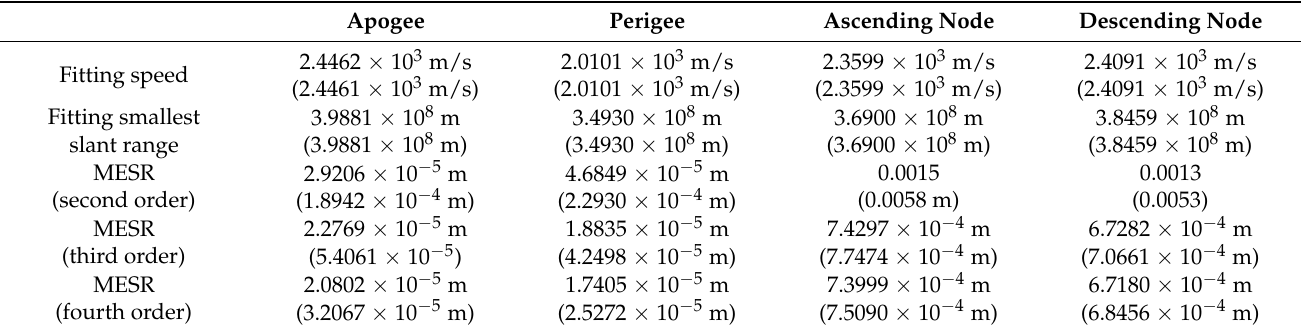
Table 5. The fitting parameters for MBS (0 ◦ , 0 ◦ ) with a look angle (left looking) about 0.3 ◦ , with the synthetic aperture time being about 80 s (contents outside brackets) and 150 s (contents inside brackets). The time of apogee, perigee, ascending, and descending nodes are consistent with the time in Tables 2 and